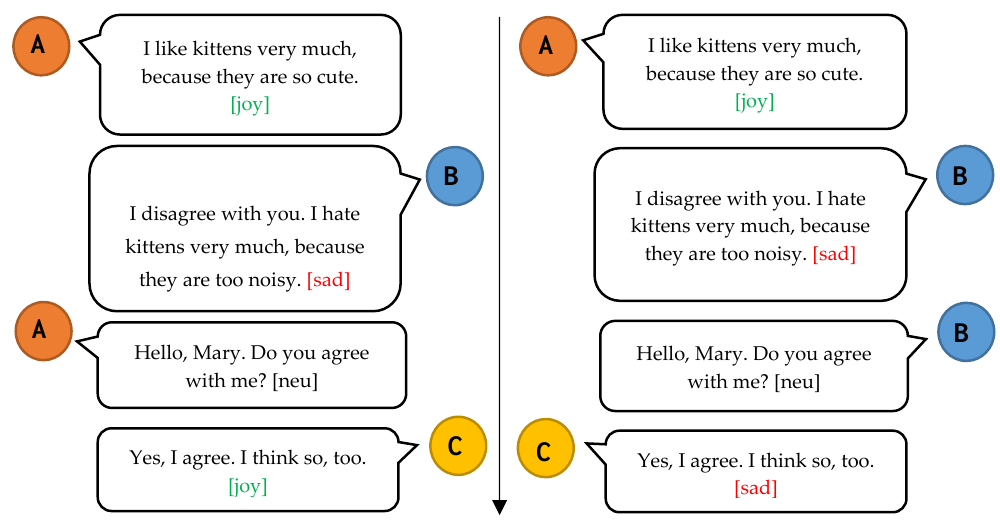
Figure 2. The utterance “Yes, I agree. I think so, too.” delivers different emotions, joy and sadness, when the previous sentence is from Person A and Person B, respectively.